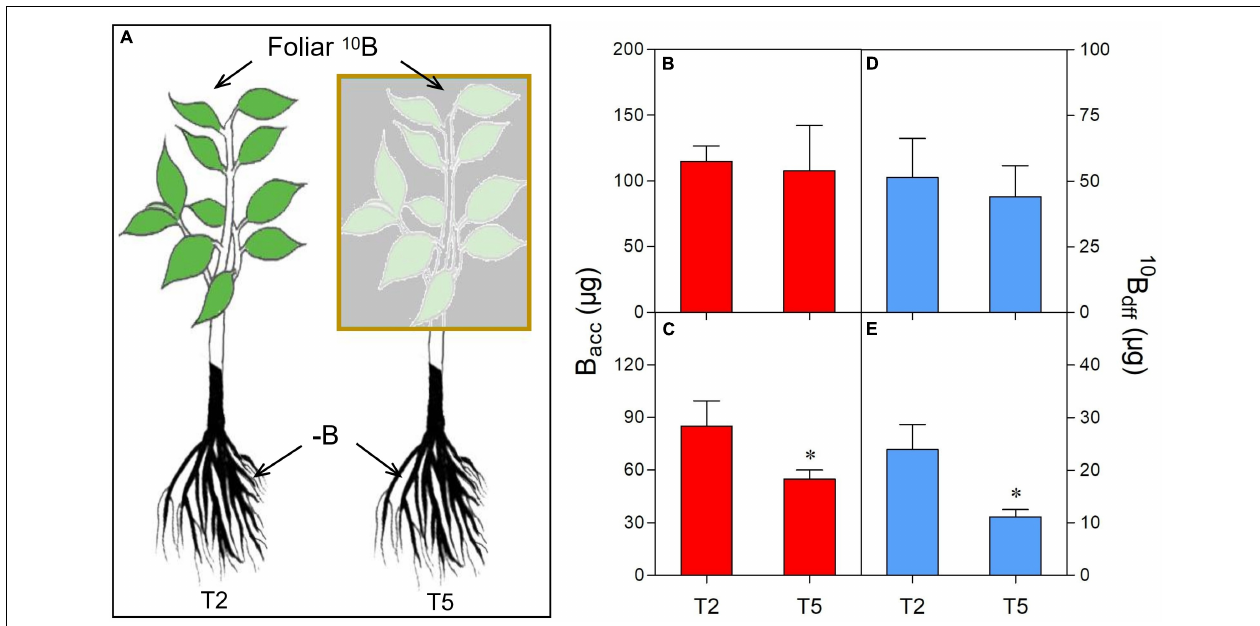
FIGURE 3 | Comparison of B accumulation (B acc ) and 10 B concentration derived from foliar 10 B ( 10 B dff ) in leaves (B,D) and roots (C,E) of different treatments (A) . The yellow box refers to shading the foliar- 10 B treated plants as treatment 5 (T5). “ ∗ ” in each graph indicates significant differences between T2 and T5 treatments ( t -test, n = 4, P <